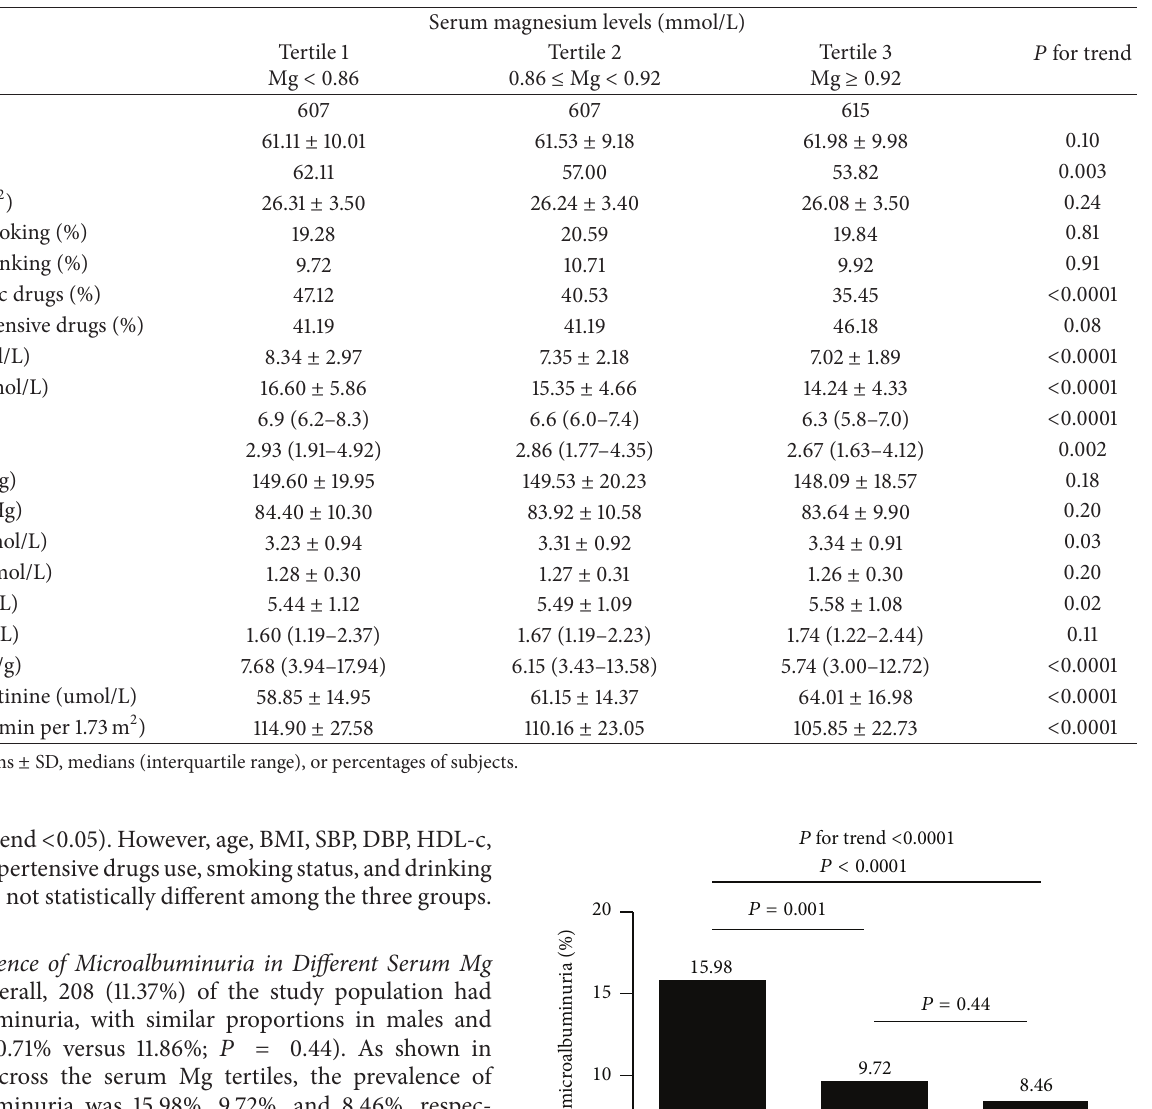
Table 1: General characteristics of the study population.